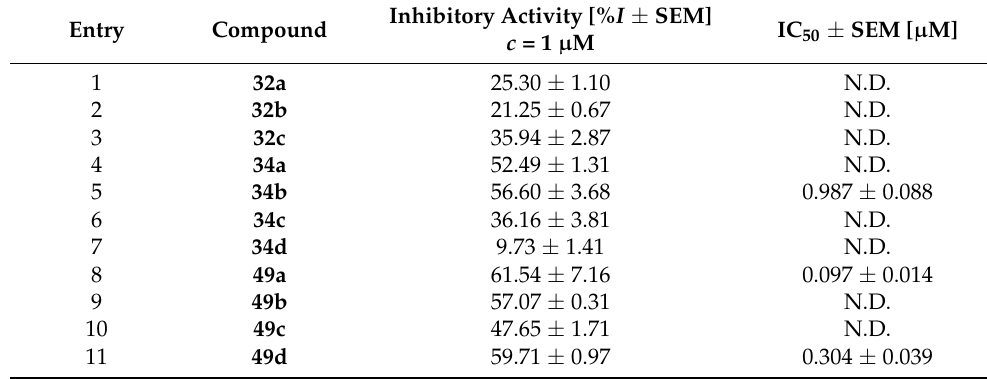
Table 4. Inhibitory activities of the optimized derivatives based on SAR evaluation.